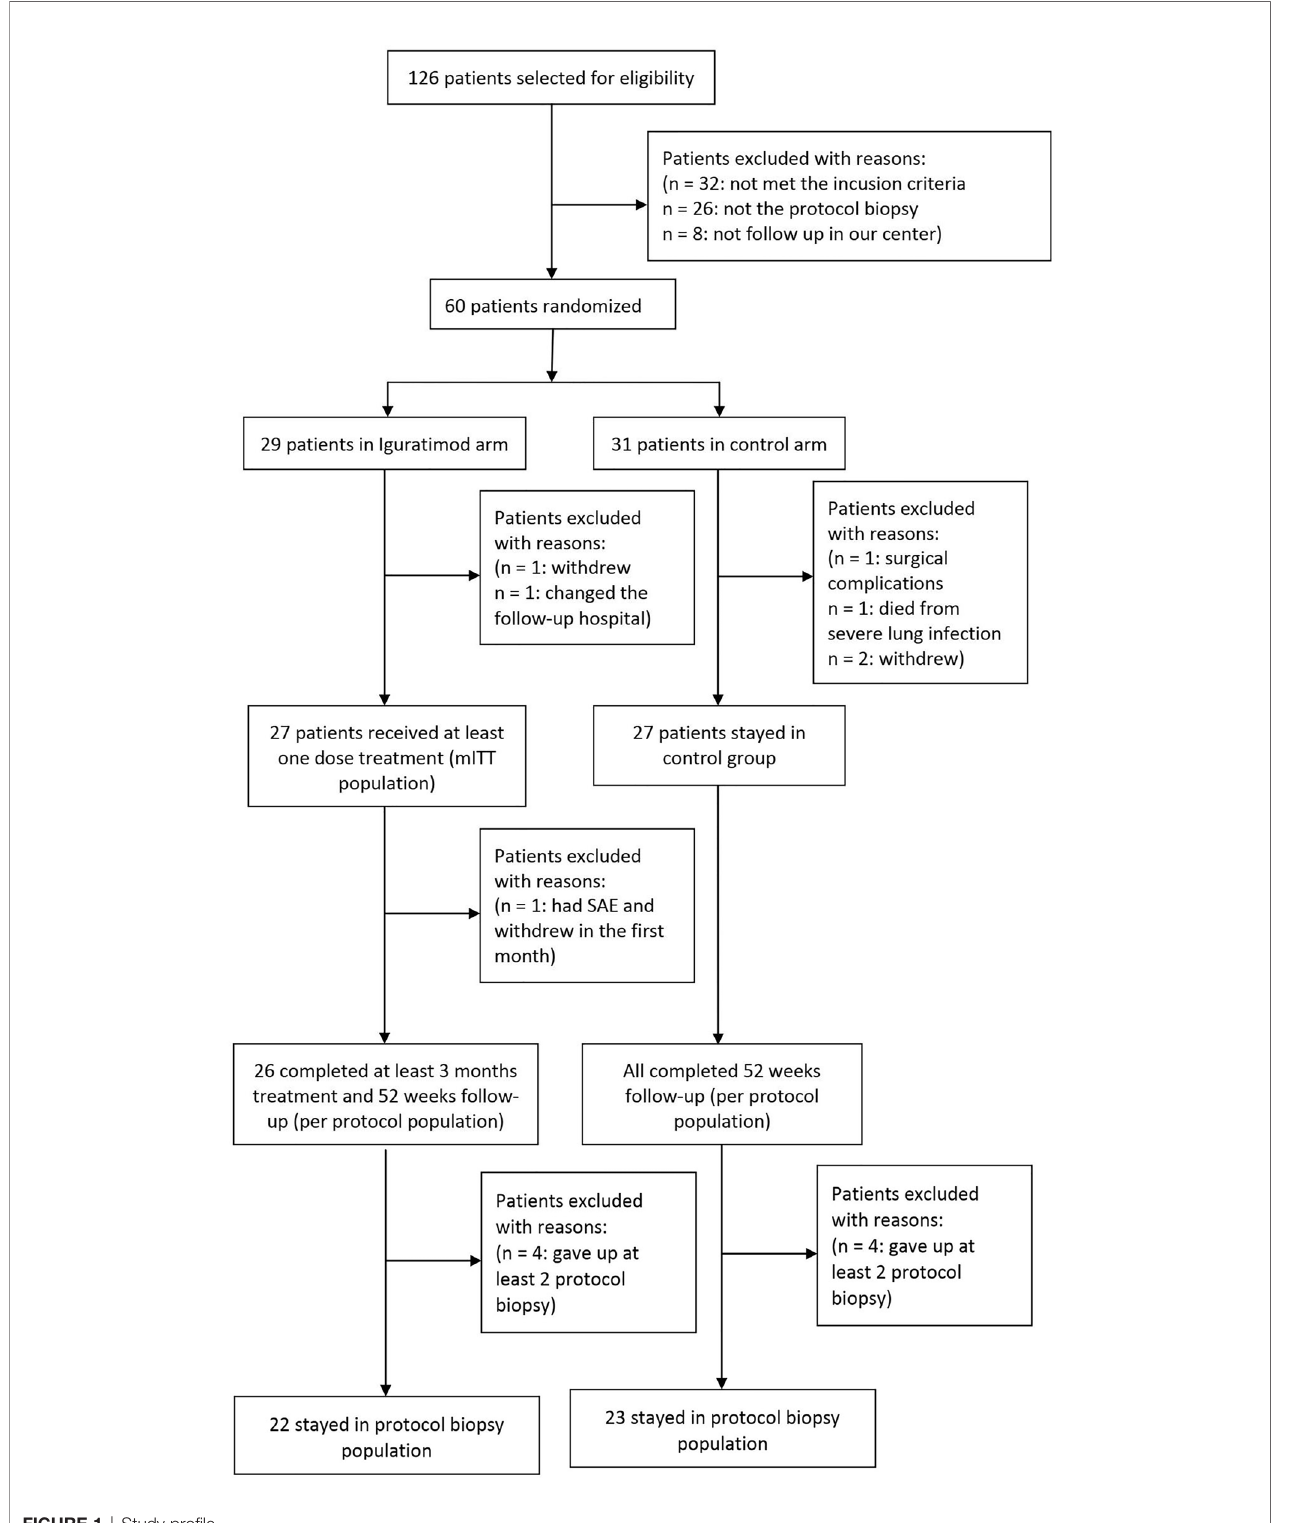
FIGURE 1 | Study pro fi